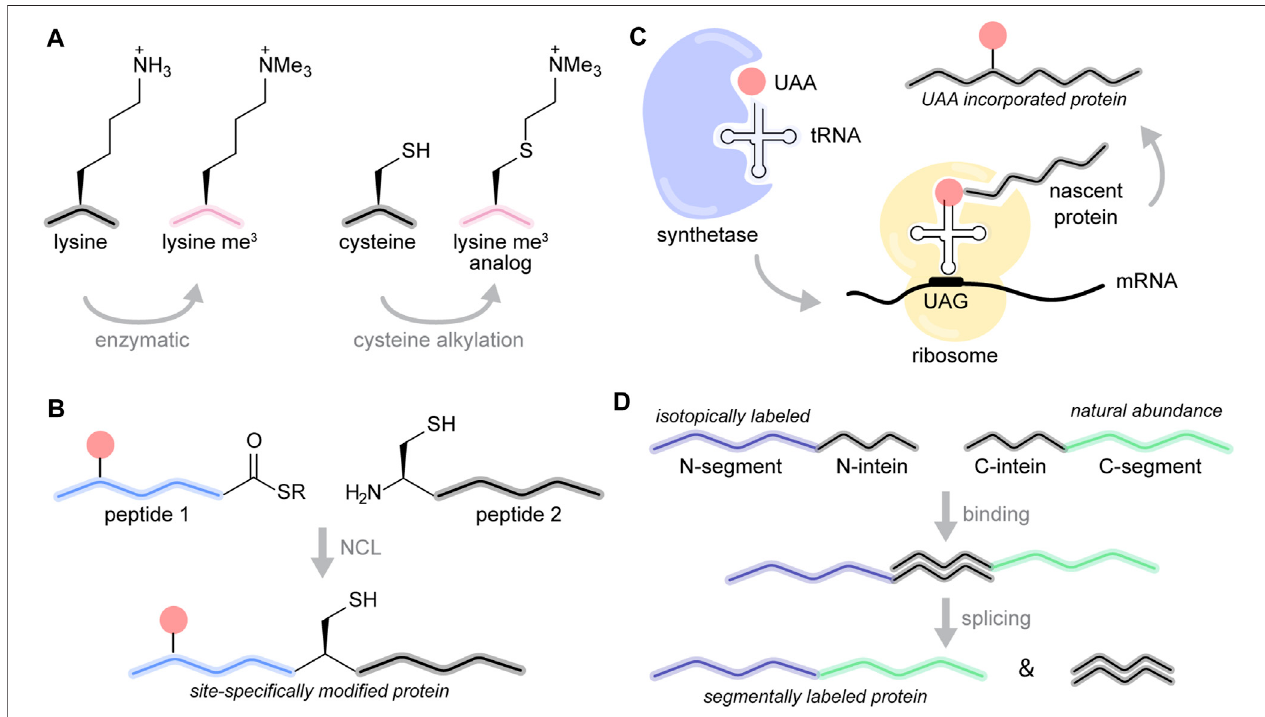
FIGURE 3 | Chemical biology toolbox for chromatin studies. ( A ) Lysine trimethylation (me 3 ) can be installed enzymatically or by cysteine alkylation to yield a methylated lysine analog. ( B ) In native chemical ligation, a synthetic peptide containing a C-terminal thioester (1) is linked to a second polypeptide bearing an N-terminal cysteine (2). ( C ) In unnatural amino acid incorporation, the UAA is loaded onto the corresponding tRNA by an engineered tRNA synthetase. The tRNA recognizes the amber stop codon UAG, allowing the ribosome to install the UAA at the desired position in the protein sequence. ( D ) Segmental isotopic labeling is mediated by intein splicing of an isotopically labeled protein segment with a segment at natural abundance, producing the full-length protein.